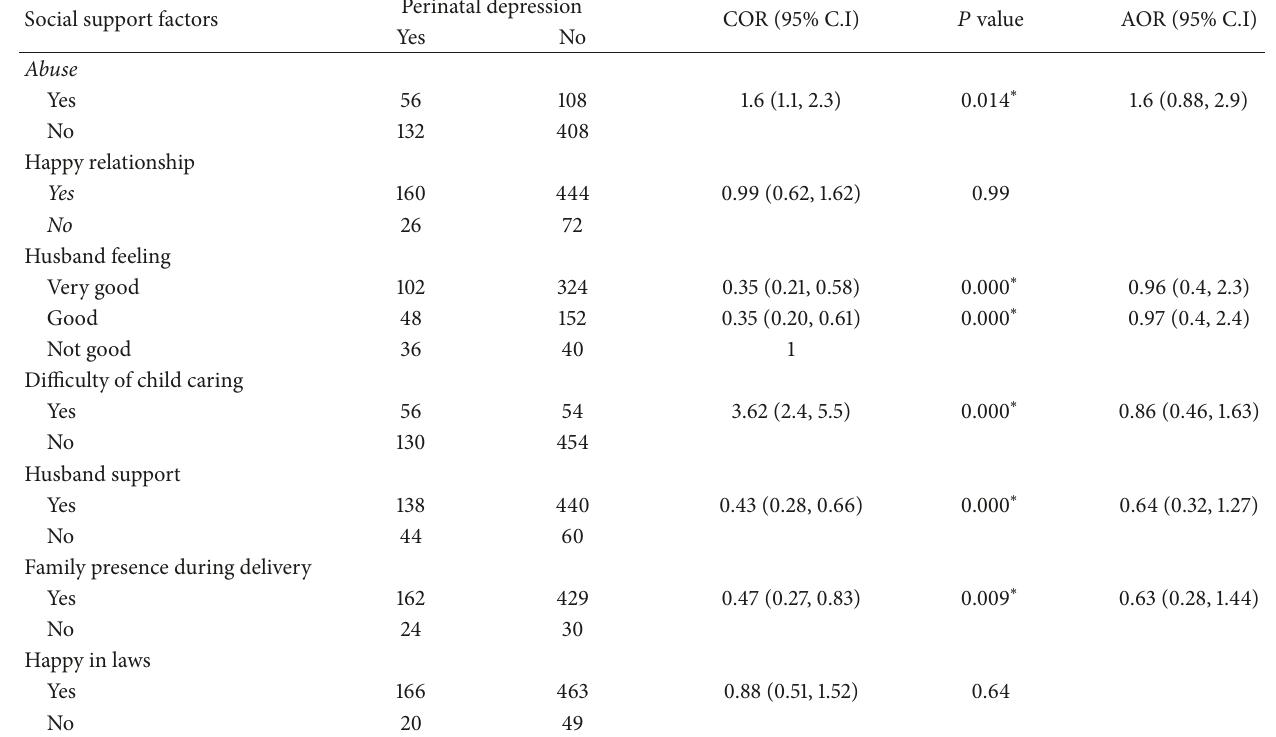
Table 7: Bivariate analysis of social support related factors of participants associated with perinatal depression, Arba Minch Zuria District, Ethiopia, March,